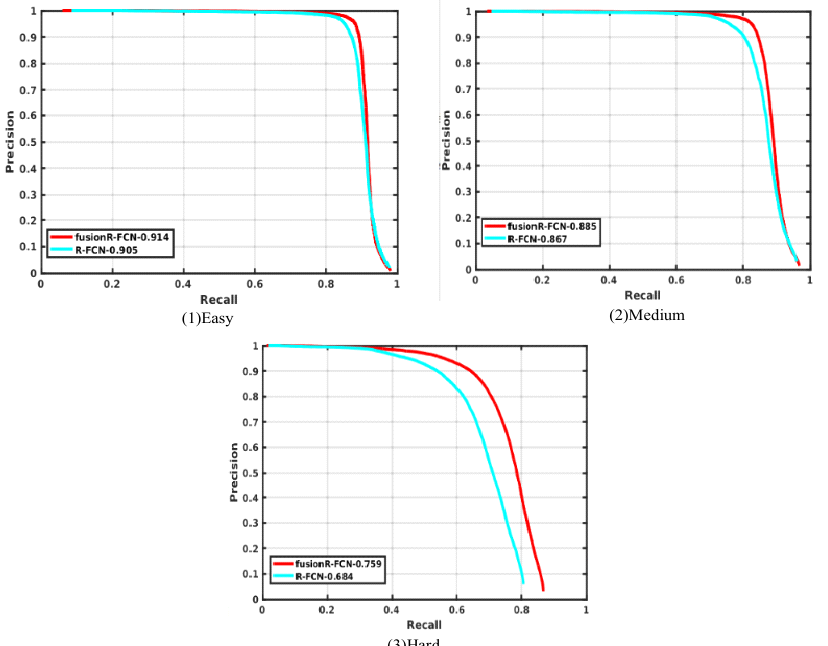
Figure 6. The precision–recall (PR) curve of f-R-FCN and R-FCN on Wider Face.